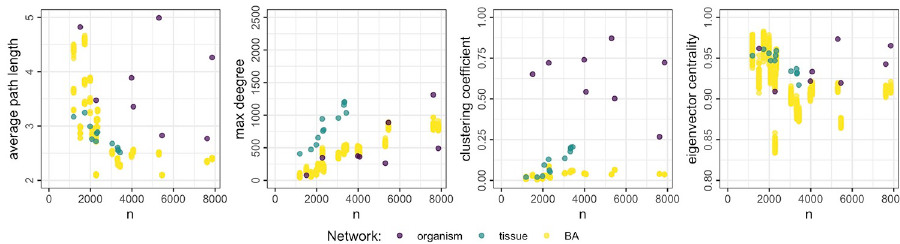
Fig 5. Distribution of four topological measures with respect to network size. The purple and teal dots correspond to the eight organism-specific networks and 12 human tissue-specific networks, respectively. Yellow dots show 50 simulated networks for each network size from the BA